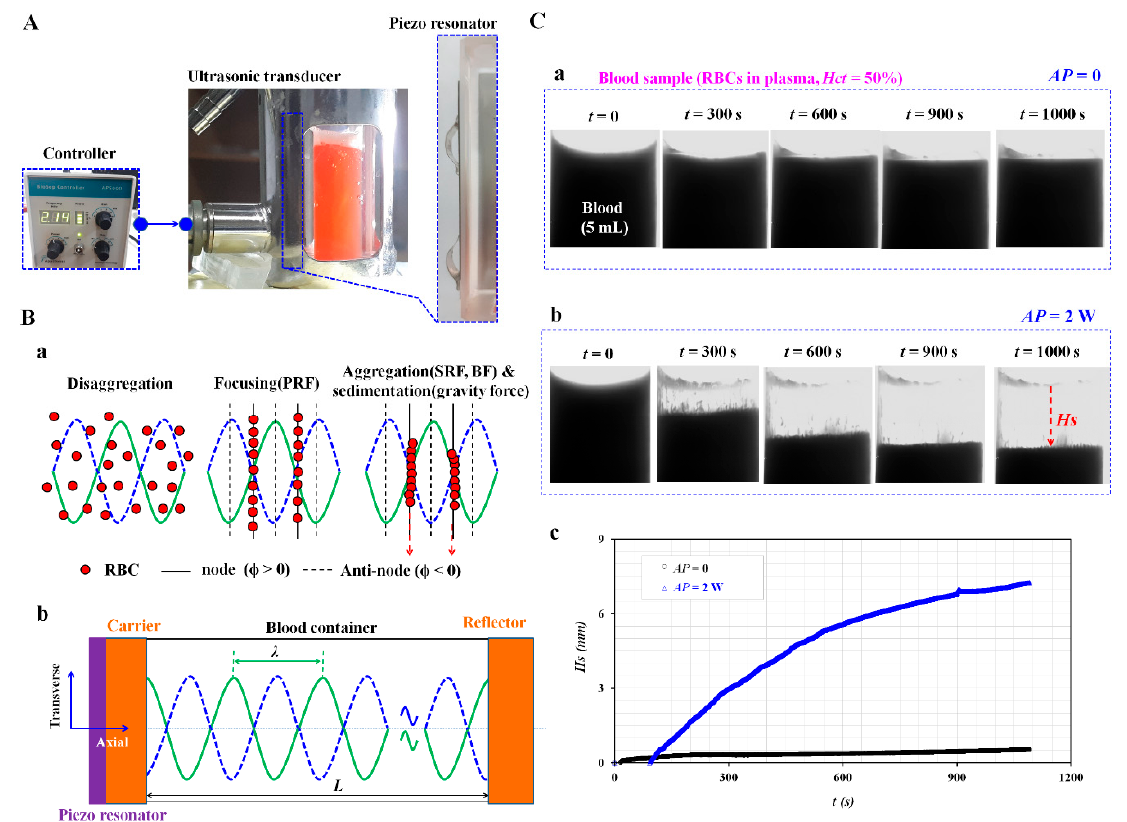
Figure 1. Proposed method for separating RBCs from blood sample with ultrasonic transducer. ( A ) Ultrasonic experimental setup, including an ultrasonic transducer and a controller. Right side panel showed piezo resonator in ultrasonic transducer. ( B ) The working principle of RBC-to-liquid separation with the ultrasonic standing wave. ( a ) Separation sequences including disaggregation, focusing, aggregation, and sedimentation. ( b ) Schematic of an ultrasonic transducer and square blood container (each width [ L ] = 12.3 mm). The ultrasonic transducer consists of a piezo resonator, carrier, and reflector. An ultrasonic standing wave of 2.1 MHz existed inside the blood container, and it remained perpendicular to the gravitational direction. ( C ) As a preliminary demonstration, the blood sample (normal RBCs in plasma, Hct = 50%, blood volume = 5 mL) was infused into the blood container. ( a ) Snapshots captured at a specific time ( t ) ( t = 0, 300, 600, 900, and 1000 s) at AP = 0. ( b ) Snapshots captured at a specific time ( t ) ( t = 0, 300, 600, 900, and 1000 s) at AP = 2 W. Hs represented the liquid height, and was used to quantify the RBC-to-liquid separation. ( c ) Temporal variations of Hs with respect to AP = 0 and 2 W.